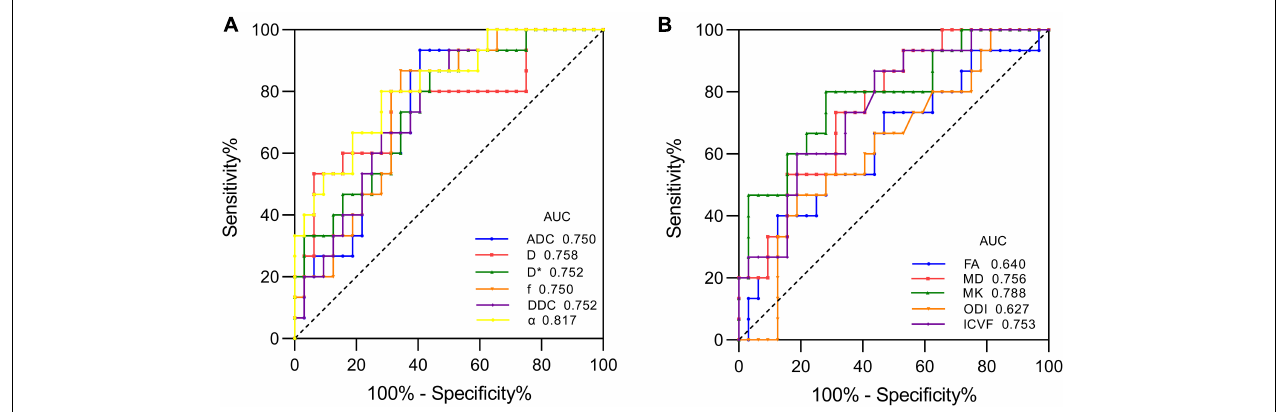
FIGURE 3 | ROC curves of each parameter for distinguishing mutant and wild-type IDH1 in LrGGs. (A) ROC curves of DWI, IVIM, and stretched-exponential DWI parameters. (B) ROC curves of DTI, DKI, and NODDI parameters. TABLE 3 | dMRI-derived parameters in LrGGs and GBMs under the same IDH1 genotype. Parameters